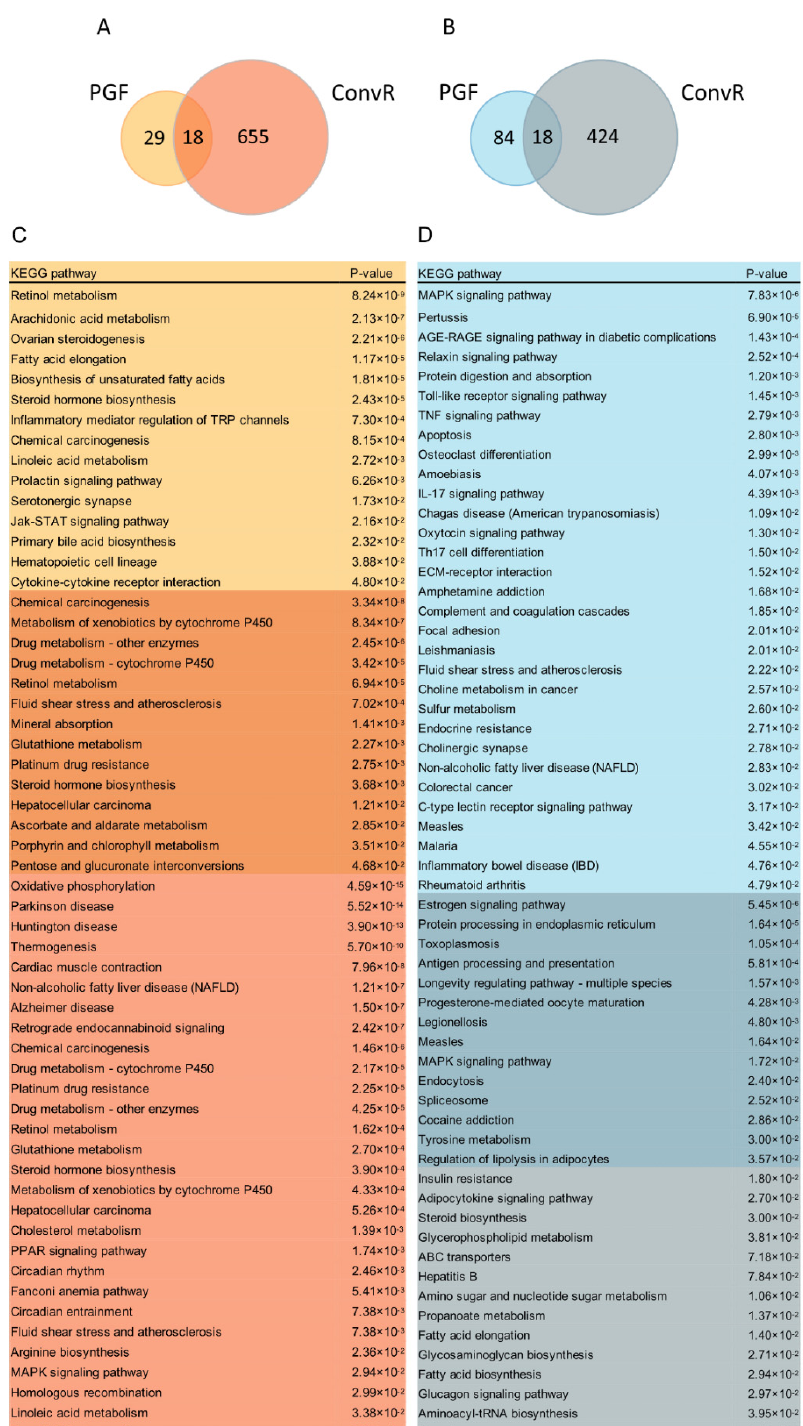
Figure 5. Regulation of hepatic transcription as a function of LS in PGF and ConvR mice. Overlap of hepatic DE genes that significantly ( A ) increase and ( B ) decrease in LS treatment mice vs. HFD-fed controls. Numbers in each portion of the Venn diagram represent the number of corresponding DE genes in each category. ( C , D ) KEGG pathway enrichment in DE up genes ( C ), and DE down genes ( D ). Orange represent DE up in PGF mice only, orange/red indicate DE up in both PGF and ConvR mice, red represent DE up in ConvR mice only. Blue indicate DE down in PGF mice only, blue/grey represent DE down in both PGF and ConvR mice, grey indicate DE down in ConvR mice only. n = 3 mice per group, significance was determined by DESeq2 with p -adjust < 0.05 and |log 2 FC| ≥